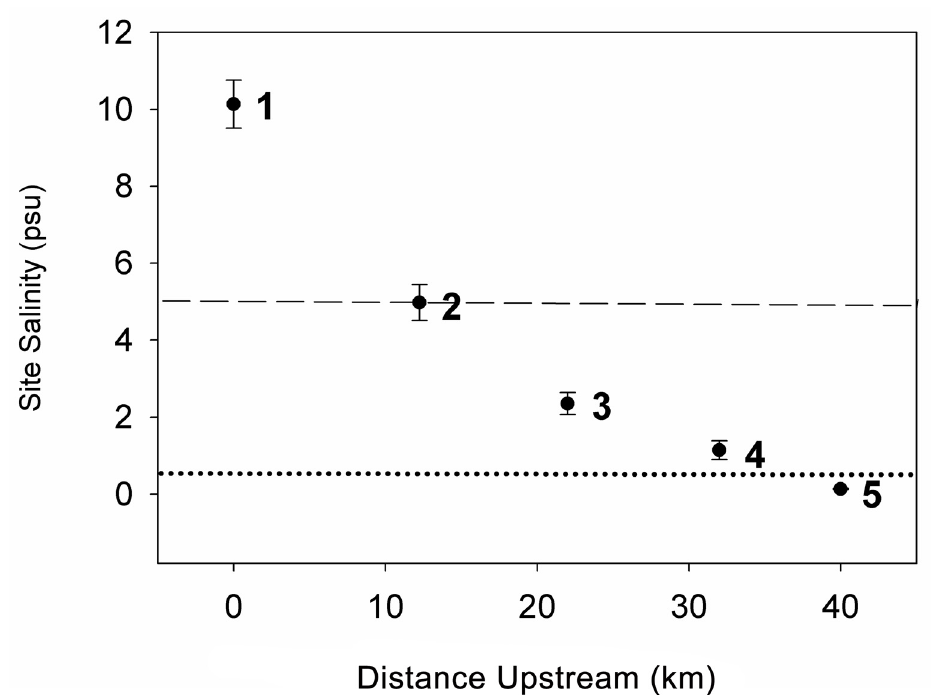
Fig 1. Salinity of study sites on the Nanticoke subestuary. Plotted values are mean ± 1 SE of measurements of marsh surface water and porewater salinity from 2007 – 2011 (n = 33 – 39 for each site mean). Porewater measurements were taken at 10 – 20 cm depths adjacent to surface elevation tables. Distance upstream is distance from Site 1 (0 km upstream). Dashed line represents the oligohaline- mesohaline salinity boundary (5) and dotted line represents the fresh-oligohaline boundary (0.5). Sites are numbered 1 – 5.